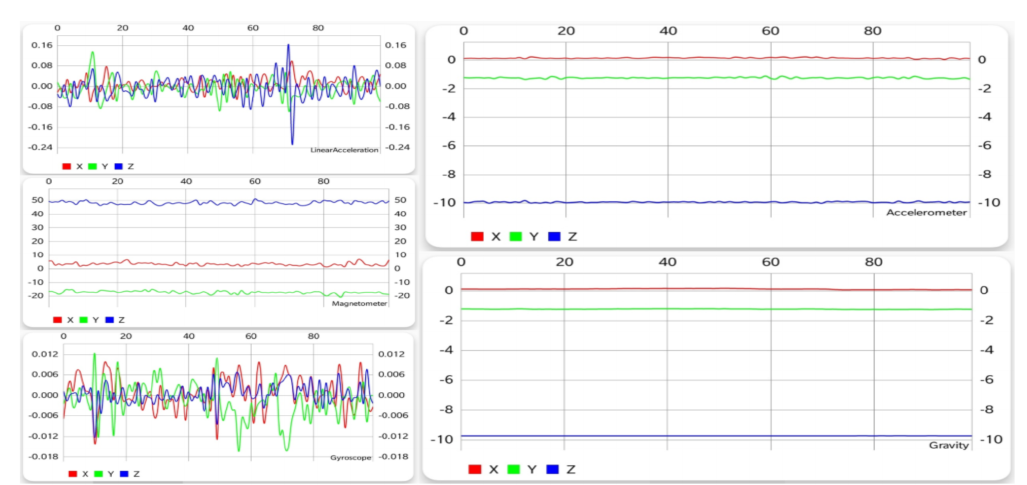
Figure 3. Graphical data gathered from each sensor while running.